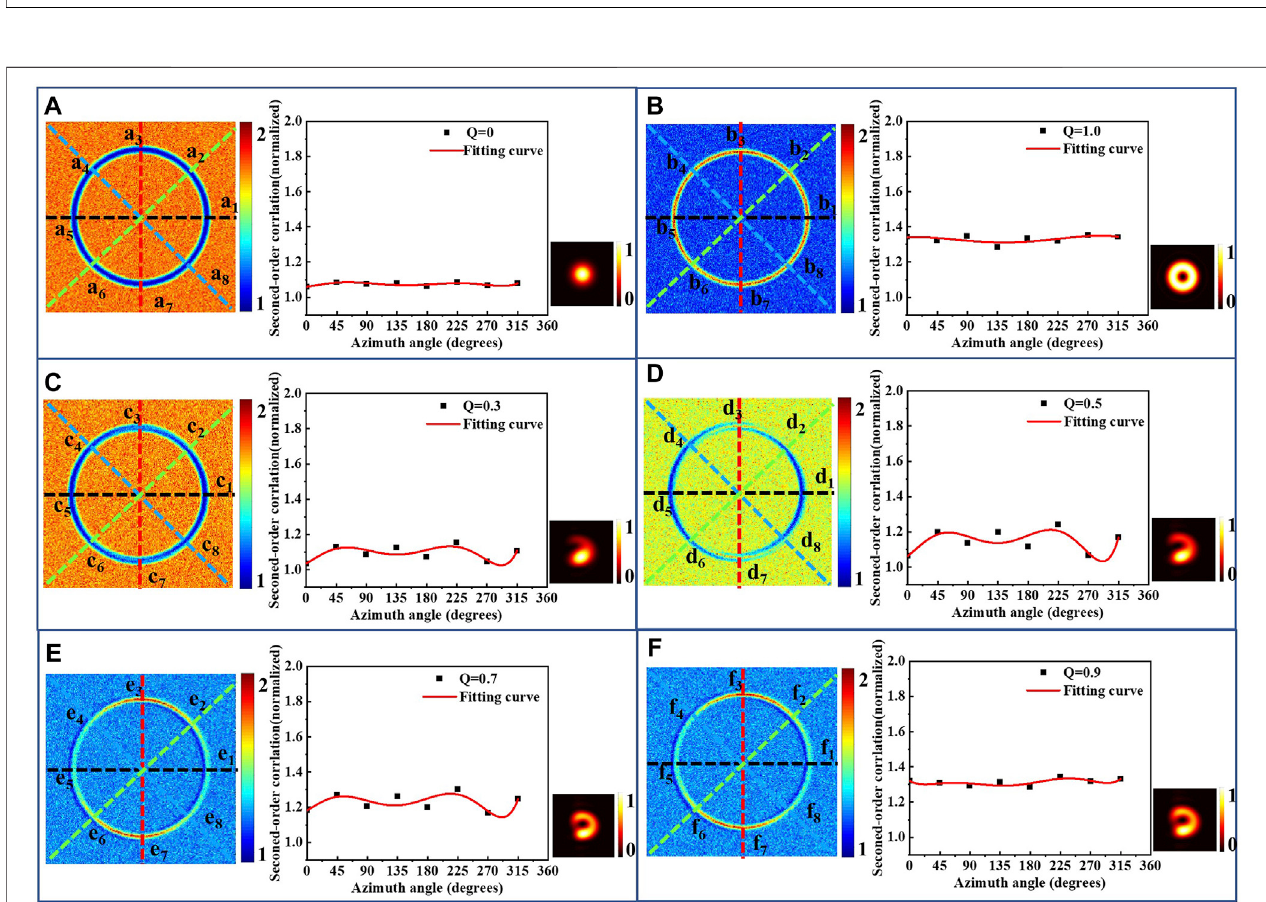
Frontiers in Physics |